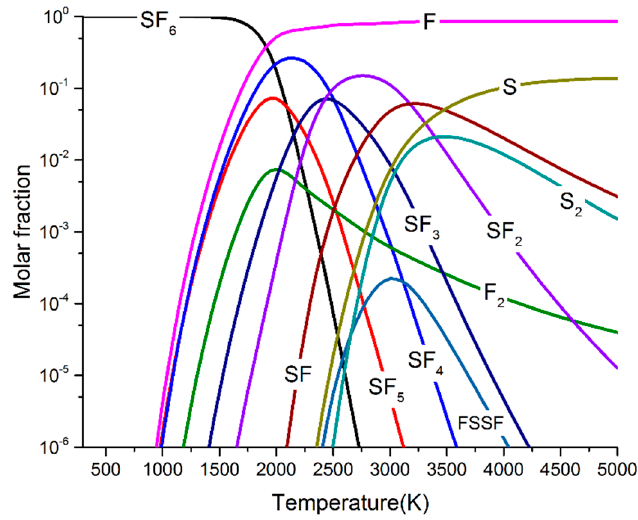
Figure 3. Particle composition of SF 6 arc plasma at 0.6 MPa.